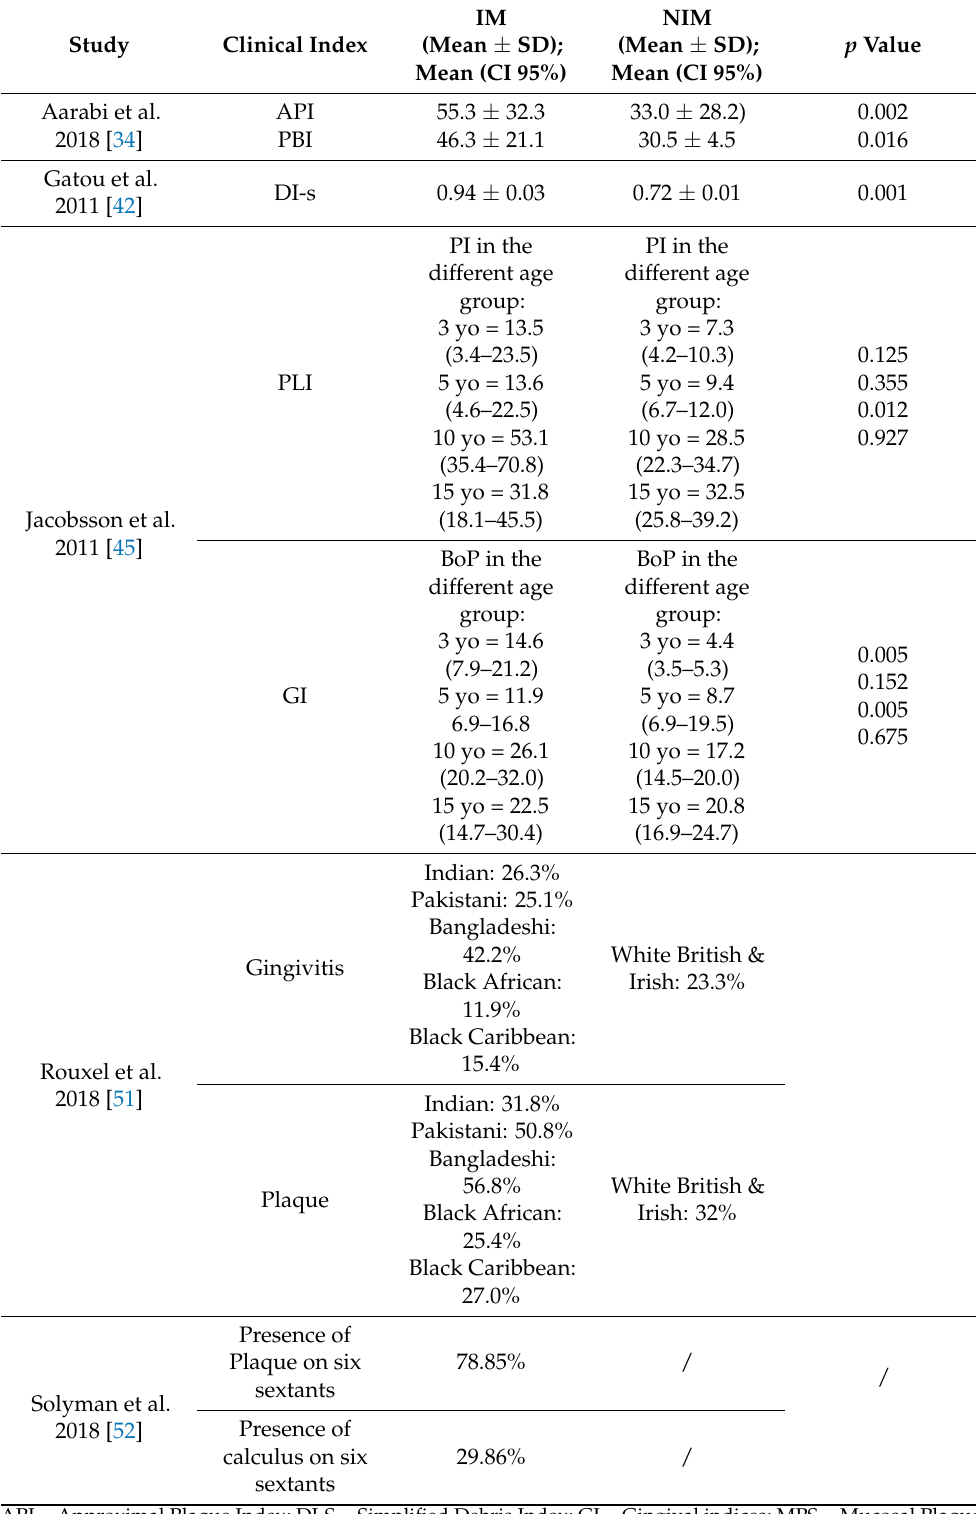
Table 10. Periodontal parameters in MI and NMI: API, PBI, DI-s. PLI, GI, presence of plaque and calculus on six